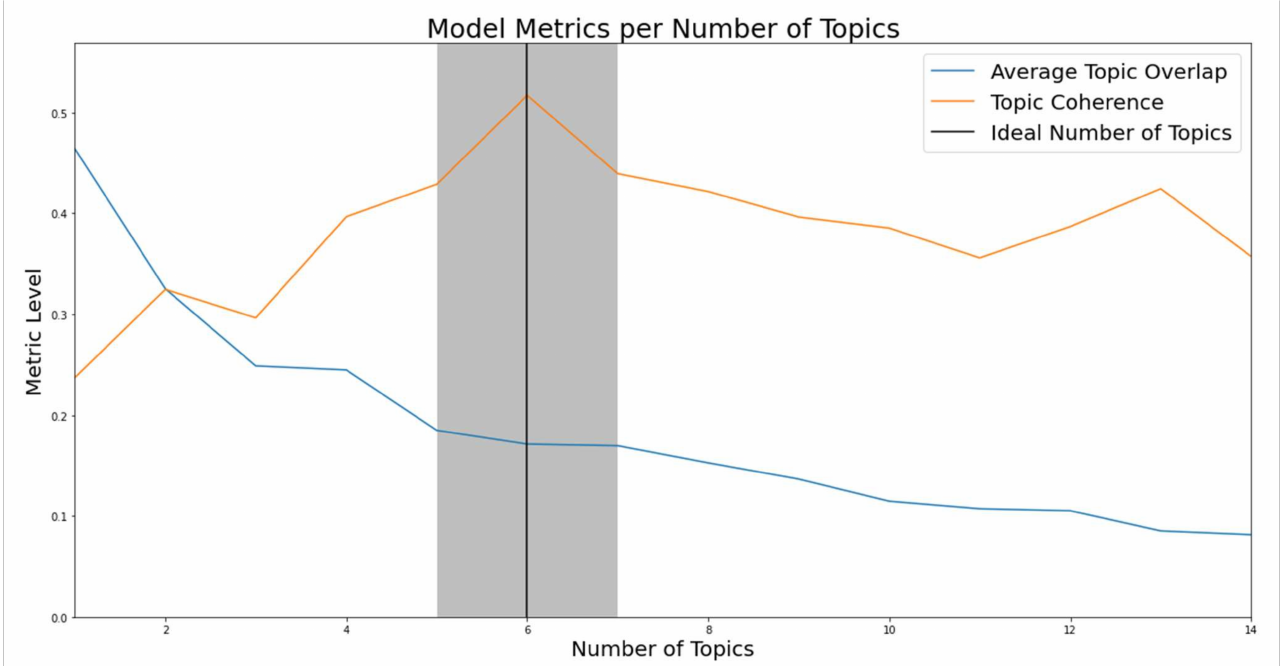
Figure 2. The measurements of an optimal number of topics of usability issues from the input